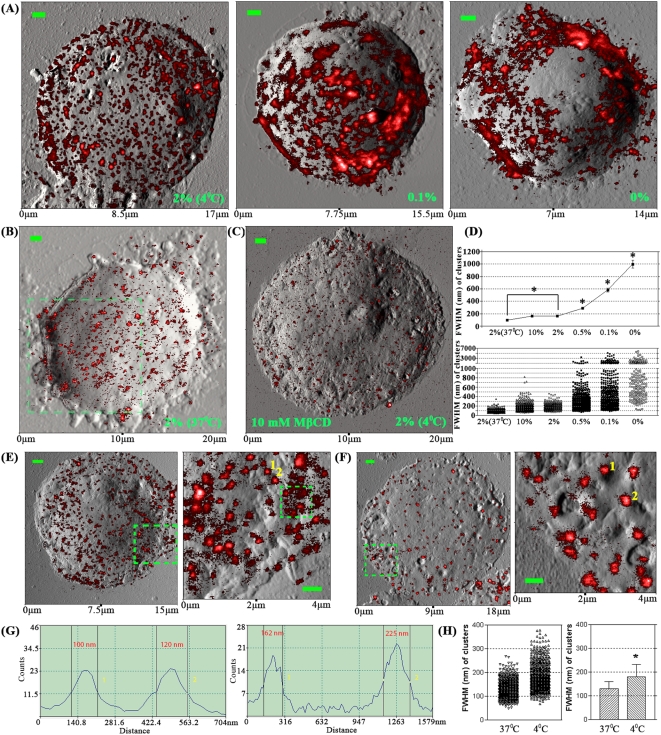
Accurate NSOM imaging and quantification of GM1/CD59 on Jurkat T cells pre-fixed by FA of various concentrations and at various temperatures.(A) NSOM images (merged from the NSOM fluorescence images in red and the corresponding topographic images in gray) show the size enlargement of GM1 clusters from nanoclusters to microclusters with the decrease in fixation strength from 2% FA to 0% no fixation. (B, C) The NSOM images of GM1 from representatives of Jurkat cells pre-fixed by 2% FA at 37°C (B) or treated with 10 mM MβCD for 30 min followed by pre-fixation with 2% FA at 4°C and fluorescence staining (C). (D) Dot graph (bottom) and X-Y plot (top; SEM±SD) of the diameters (FWHM) of the GM1 micro/nanoclusters on cells (5 cells/group) pre-fixed with 0%, 0.1%, 0.5%, 2%, 10% FA at 4°C, and 2% FA at 37°C, respectively. (E, F) NSOM images of CD59 on a representative cell (Left) pre-fixed by 10% FA at 4°C (E) or at 37°C (F) and the boxed part (right) of it; (G) The fluorescence profiles of the cross sections across the centers of the two CD59 nanoclusters indicated by numbers 1 and 2 in Fig. E (left of Fig. G) or F (right). (H) Dot (left) and bar (right; Mean±SD) graphs of the diameters (FWHM) of the CD59 nanoclusters on cells (5 cells/group) pre-fixed with 10% FA at 4°C and at 37°C, respectively). Scan size: (A: left to right) 14×14 μm2; 15.5×15.5 μm2; 17×17 μm2. (B, C) 20×20 μm2; (E: left to right) 18×18 μm2; ∼4×4 μm2; (F: left to right) 15×15 μm2; ∼4×4 μm2. Scale bar/resolution: (A–C, and left panels of E and F) 1 μm/500×500 pixel2; (right panels of E and F) 500 nm/300×300 pixel2. Integration time: (all) 30 ms.